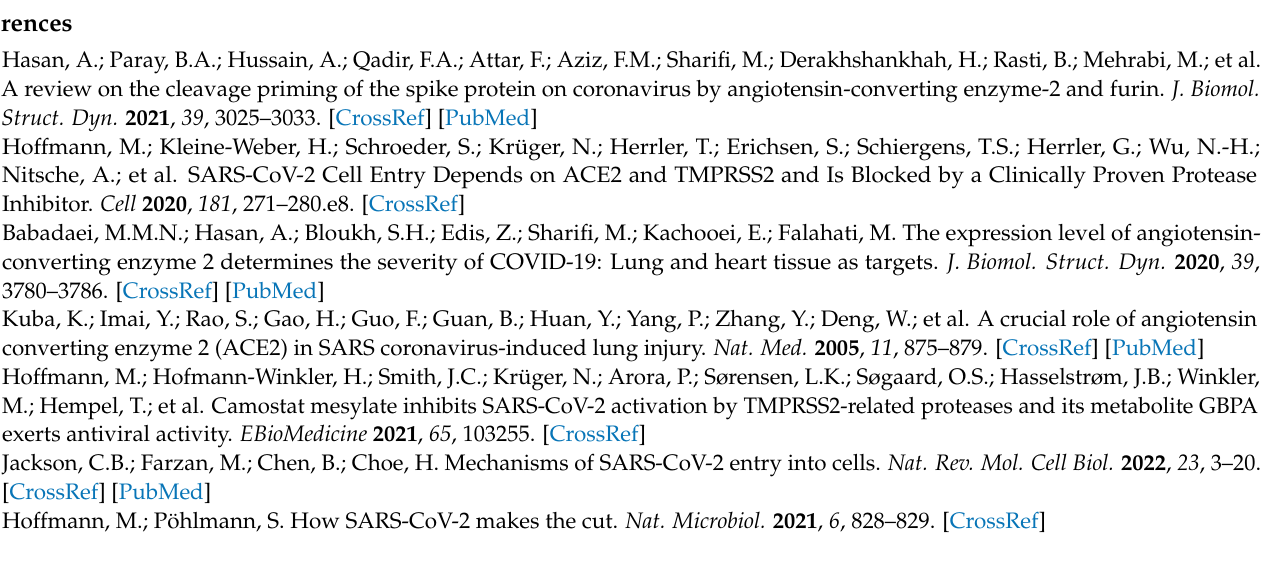
mice. Figure S2: Viral load and infectious-virus titers after infection with SARS-CoV-2 Beta and Omicron in brain tissue. Figure S3: TMPRSS2 affects the Type I interferon response in SARS-CoV-2 infected